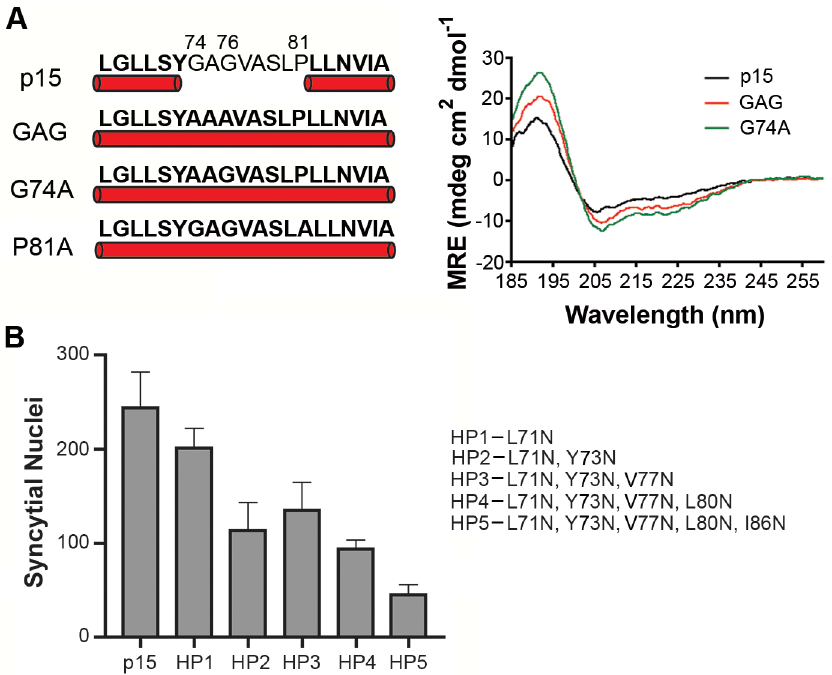
Fig 2. Helical properties and hydrophobicity influence the function of the p15 HP. (A) Secondary structure predictions (left panel) of the wt p15 HP sequence and the indicated p15 HP Ala substitutions (GAG contains a double substitution of G74/76A) as predicted using Phyre 2 analysis (http://www.sbg.bio.ic.ac.uk/ phyre2) of the complete p15 endodomain. Residues predicted to be -helical are bolded and underscored with a cylinder. Far-ultraviolet CD spectra (right panel) of wt p15HPpep or the Ala-substituted GAG or G74A p15HPpep peptides depicted on the left were obtained at 37°C in the presence of LPPG micelles. Measurements were collected from three runs in each of two independent experiments and converted to mean residue ellipticity (MRE). (B) QM5 cells expressing wt p15 protein or mutant p15 proteins (HP1-5) containing asparagine substitutions of HP residues indicated on the right were fixed at 10 h post transfection, Giemsa-stained, and quantified for the average number of syncytial nuclei. Results are mean SEM of triplicate samples from n = 3 independent